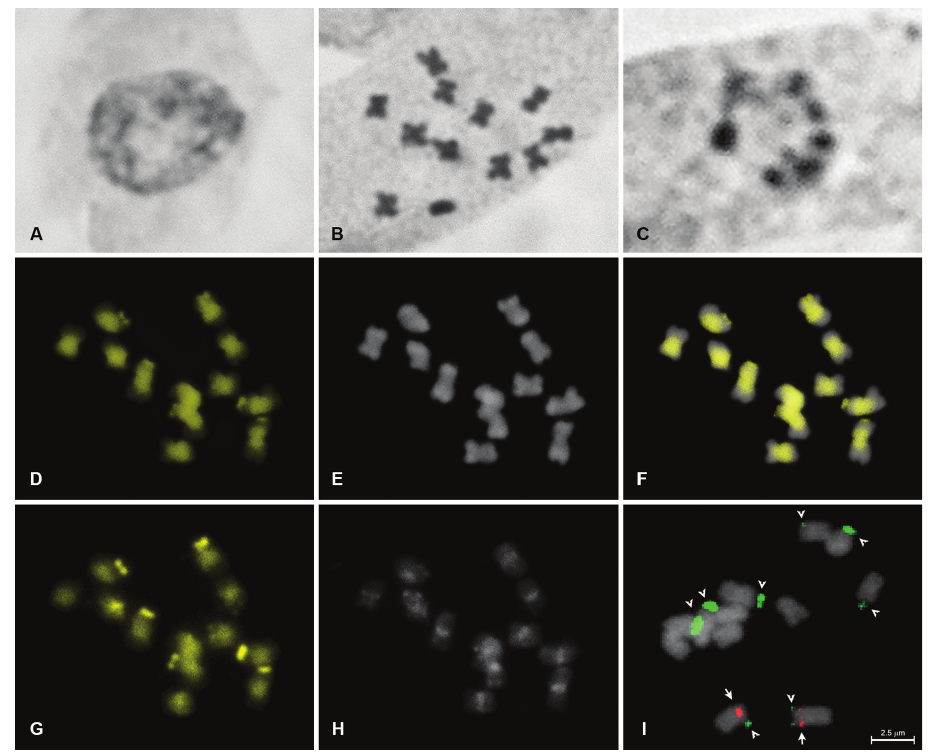
Figure 2. Karyotype analysis of Euphorbia hyssopifolia (2n = 12). Standard staining of mitotic interphase nucleus ( A ); standard staining of mitotic metaphase ( B ); silver impregnation of mitotic interphase nu- cleus ( C ); fluorochrome banding of metaphase chromosomes stained with CMA ( D ) and DAPI ( E ) and superposed images ( F ); C-banding of chromosomes stained with CMA/DAPI (C-CMA/DAPI; G–H ); and metaphase chromosomes hybridized with 5S (red) and 45S (green) rDNA probes ( I ). Arrows and arrowheads indicate 5S and 45S rDNA sites,